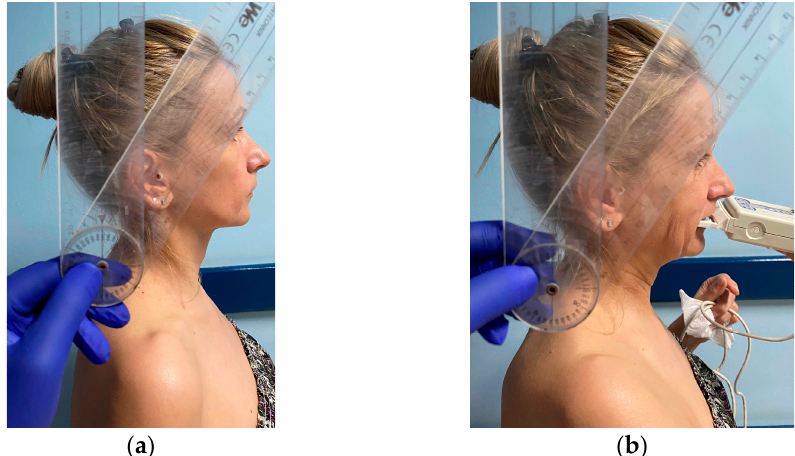
Figure 2. ( a ) Measurement of the neck flexion angle with a manual goniometer in NHP; ( b ) T-Scan registration in NHP.